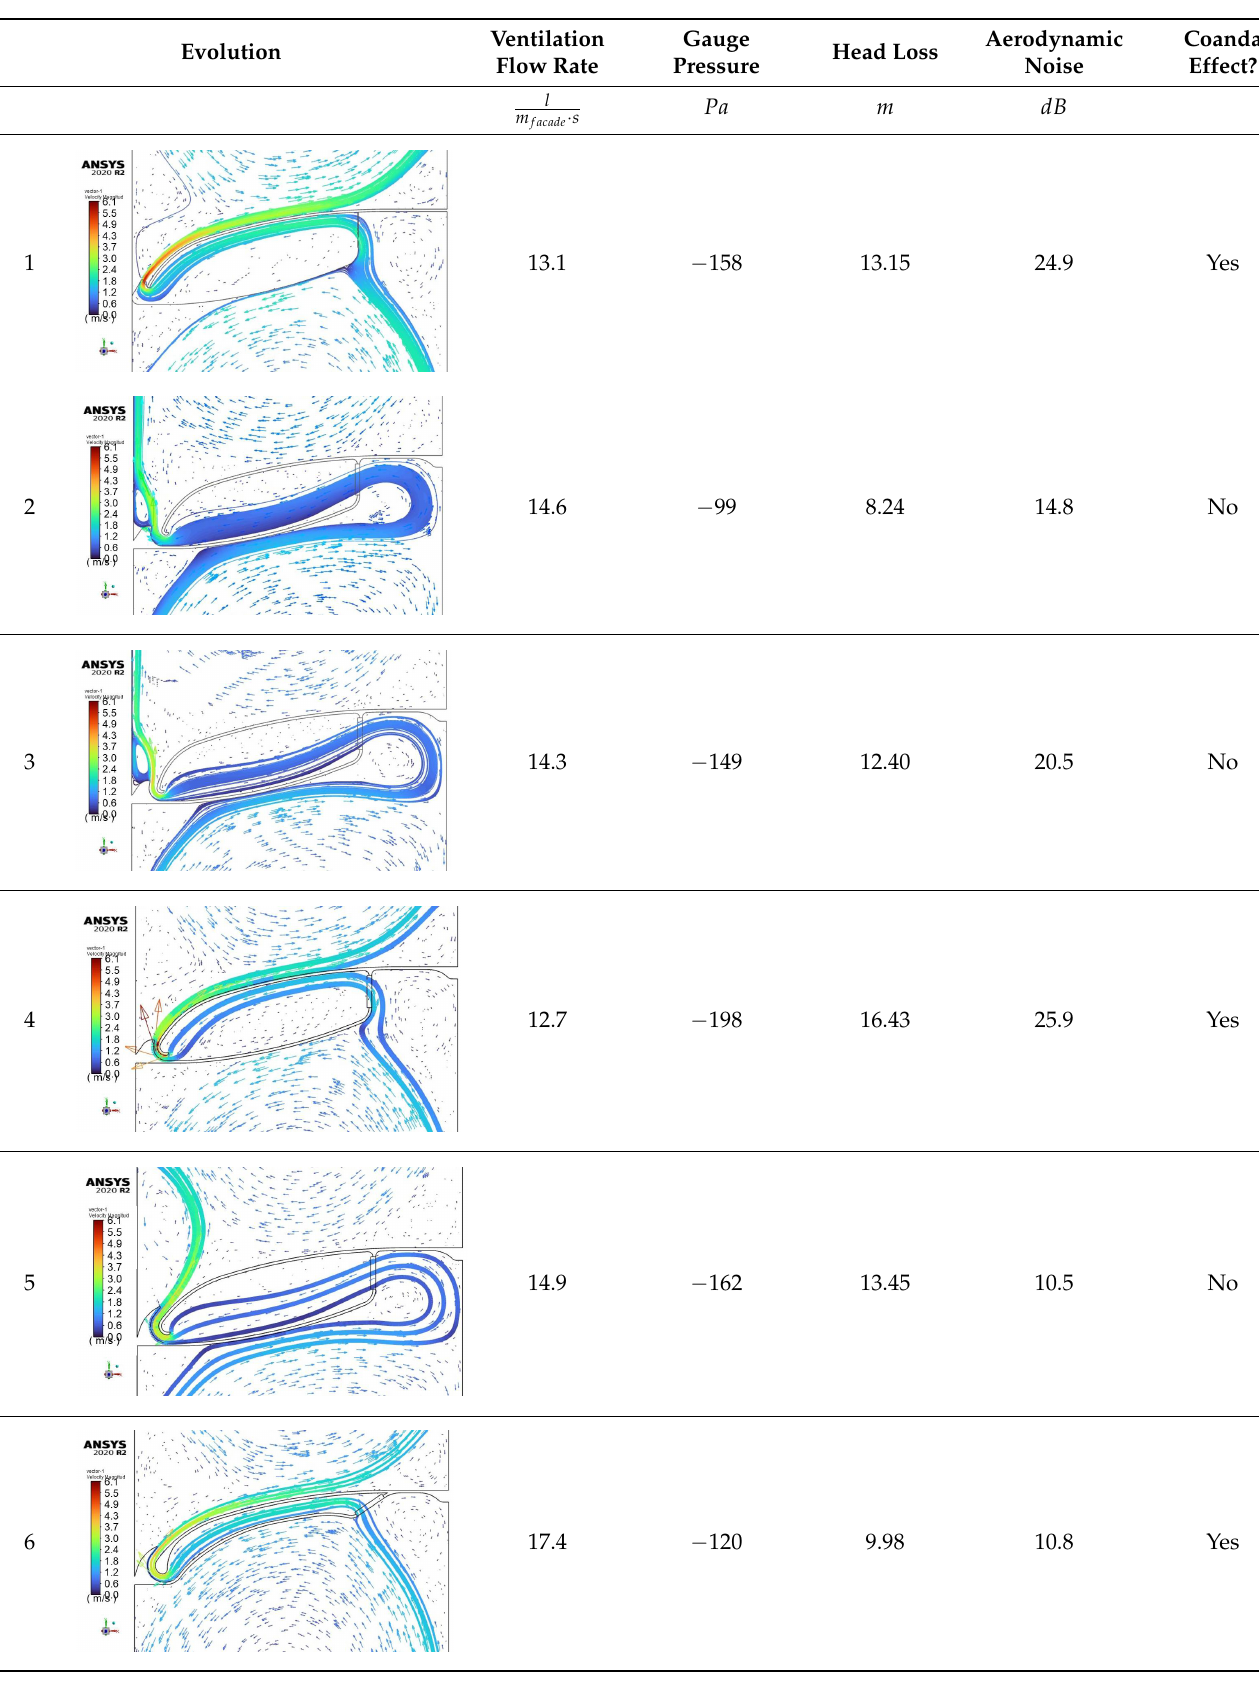
to 10.8 dB). Table 7. Key performance indicators of the façade system. Table 7. Key performance indicators of the façade system. Ventilation Gauge Pres- Table 7. Key performance indicators of the façade system. Evolution Head Table 7. Key performance indicators of the façade system. Flow Rate Table 7. Key performance indicators of the façade system. Table 7. Key performance indicators of the façade system.